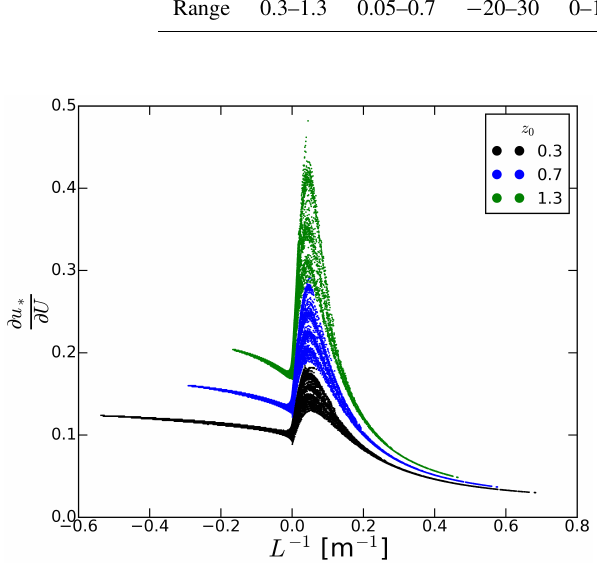
Figure 4. Cross sensitivity between atmospheric stability ( L − 1 ) and friction velocity ( u ∗ ) with respect to wind speed ( U ) for different surface roughness lengths ( z 0 ). Not all z 0 values in the range are plotted for clarity. Note that the y axis of Fig. 4 is not scaled as in the previous figures because there is no intercomparison between different input data in this